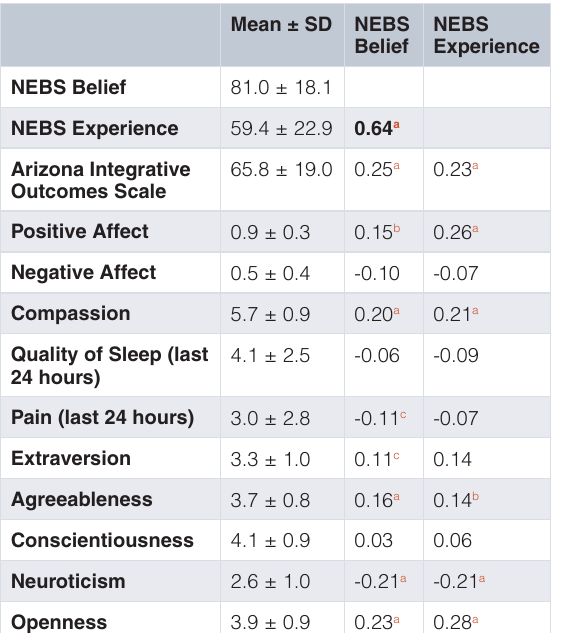
Table 4. Means, standard deviations and Pearson’s r correlation coefficients for NEBS and other questionnaires administered to IONS Discovery Lab sample. Notes: a = p < 0.00005; b = p < 0.001; c = p < 0.05; NEBS - Noetic Experience and Belief Scale. Bold font represents Pearson r values that are moderately correlated ( r =